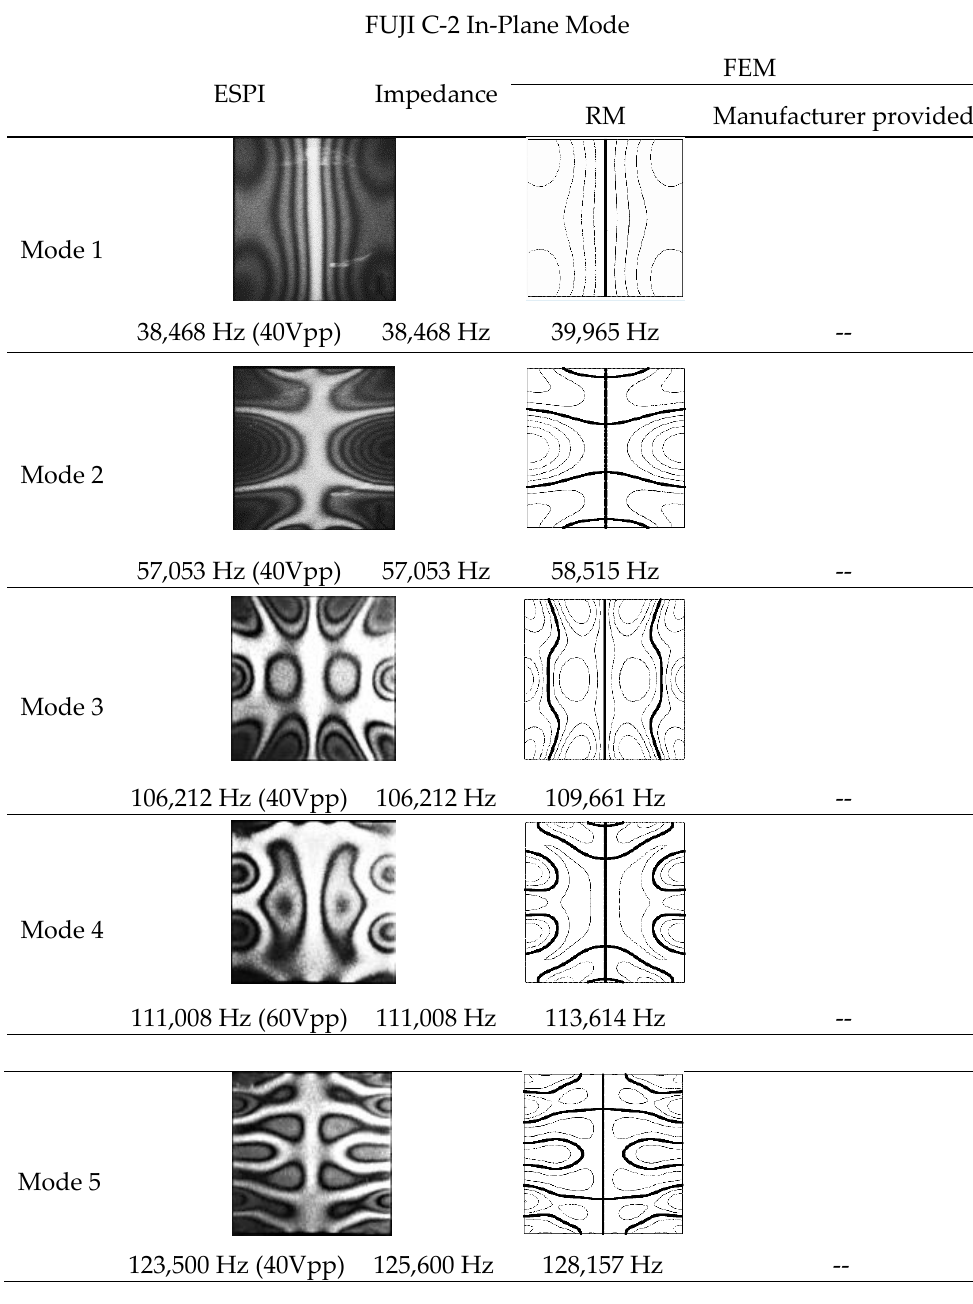
Figure 8. In-plane vibration modes for FUJI C-2.